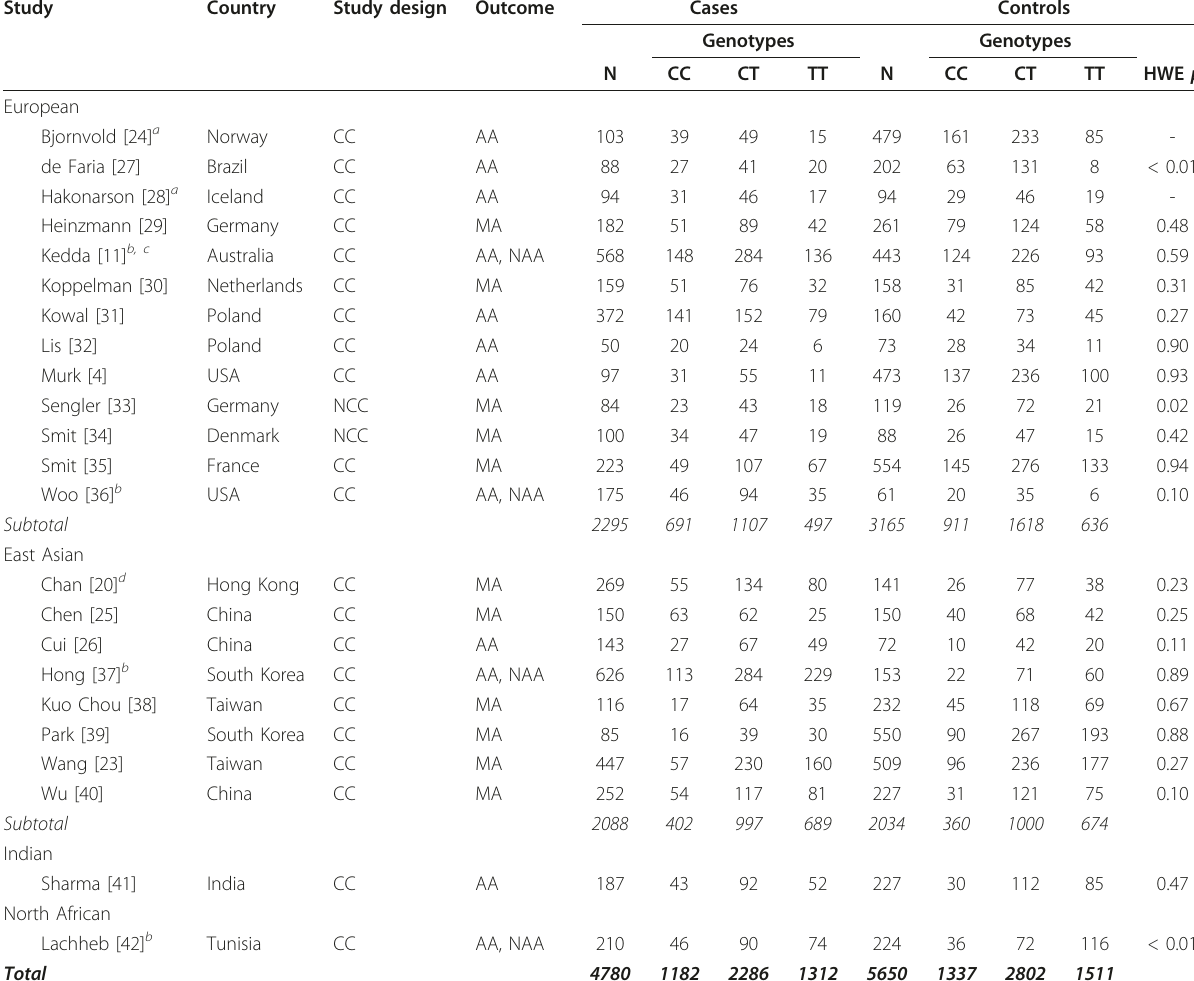
Table 1 Characteristics and genotype distributions of reviewed studies on CD14 -260 ( -159 ) C>T and asthma